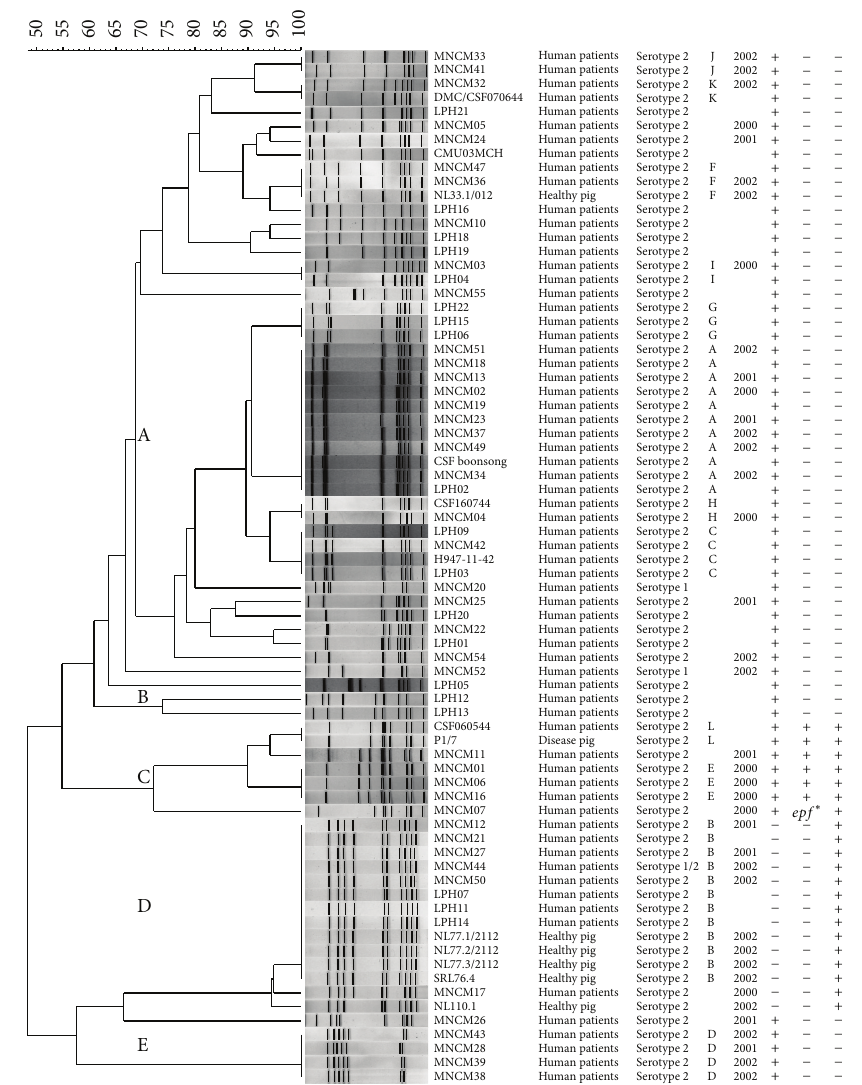
Figure 1: Dendrogram showing the relationship between PFGE groups, mrp-epf-sly genotypes of S. suis serotype 2 isolates, and P1/7 reference strain.